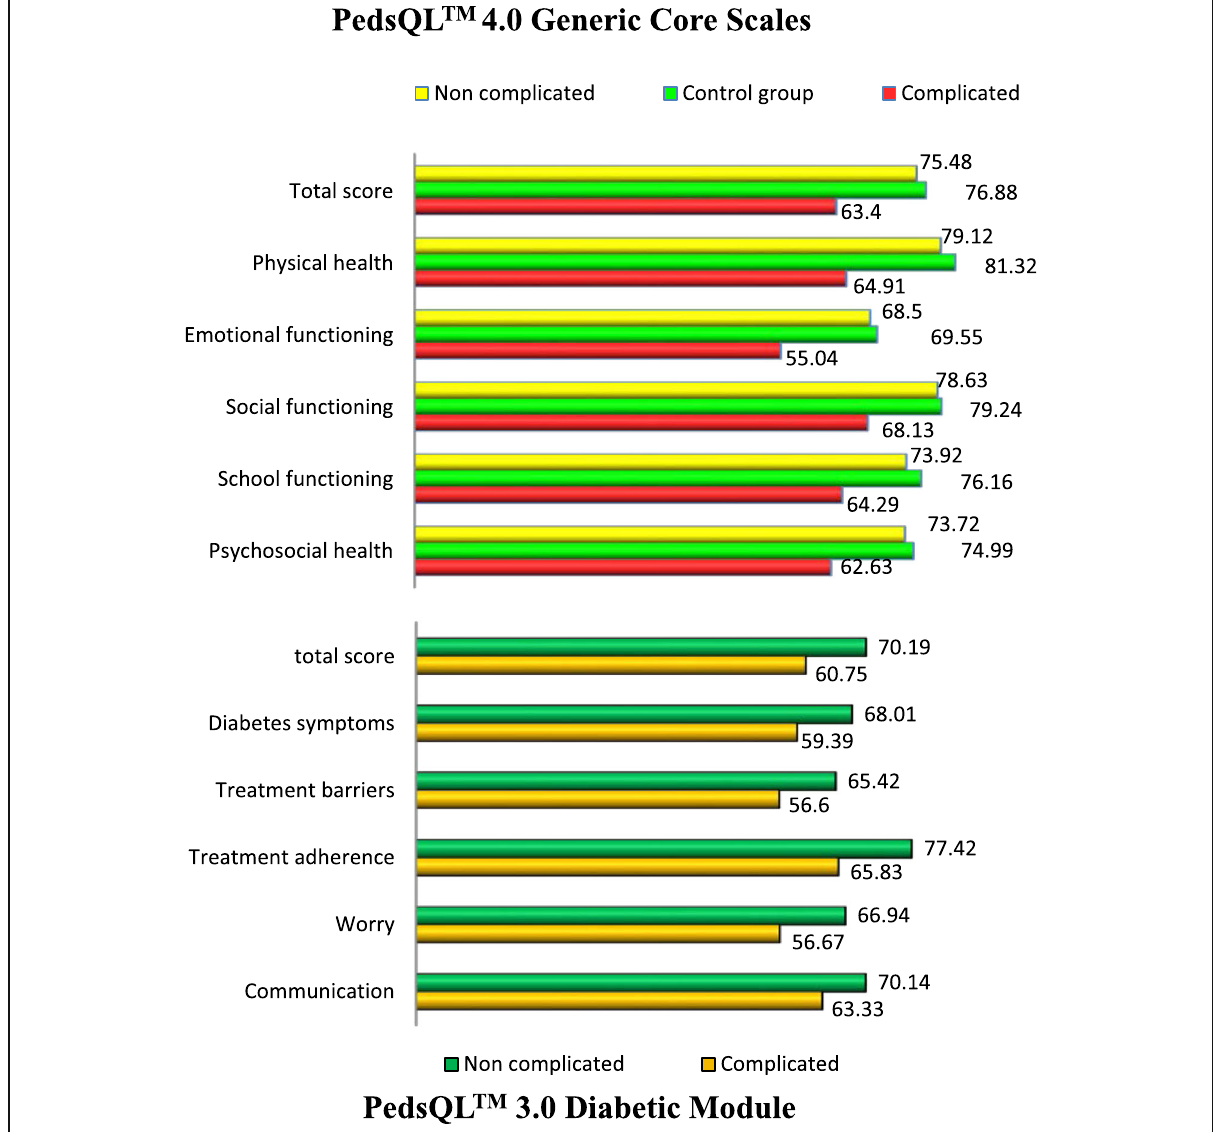
Fig. 2 Column chart showing comparison between complicated and non-complicated groups concerning their PedsQL ™ 4.0 Generic Core Scales and PedsQL ™ 3.0 Diabetic Module